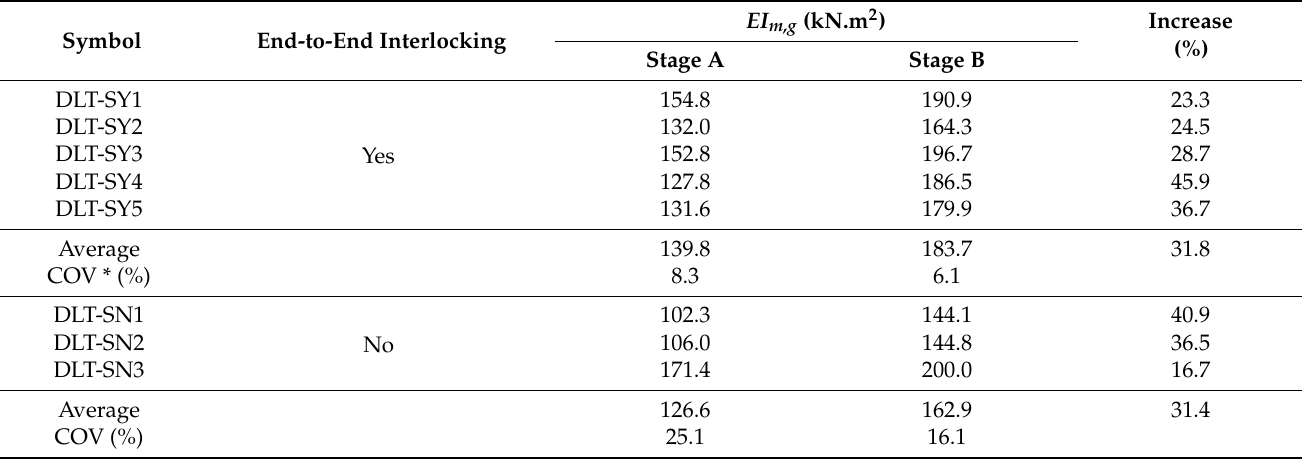
Figure 6. The load–deflection curves of the small-scale DLT panels with and without end-to-end interlocking (the applied load was set slightly higher than intended in the first specimen with end-to-end interlocking). Table 1. The global bending stiffness EI m,g of the small-scale DLT